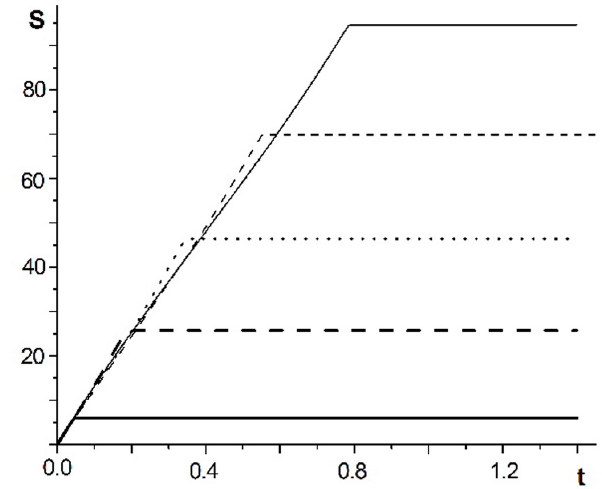
Fig. 4. Amplification factors versus time for the same five rays as in Fig.